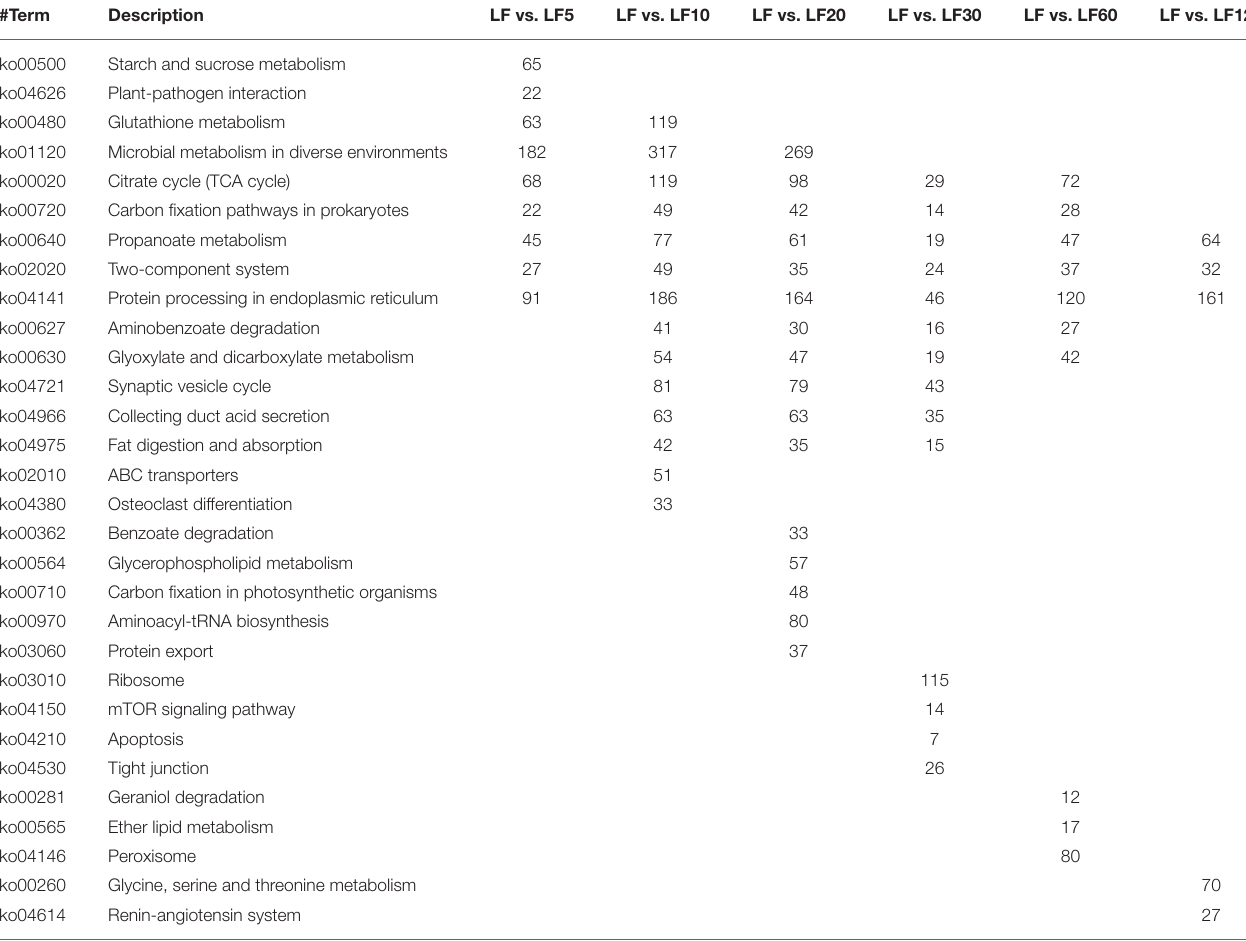
TABLE 4 | The KEGG ortholog classification of differentially expressed genes between the susceptible and the resistant